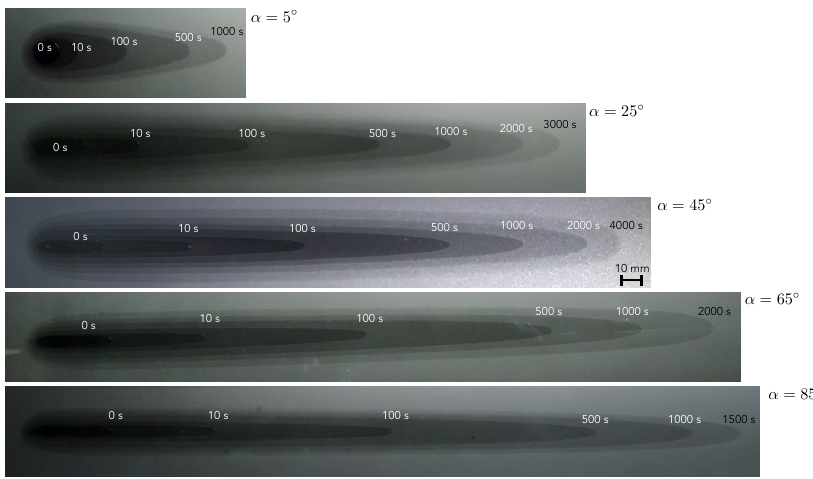
Figure 4: Silicone oil – Superimposition of several pictures of the oil stain, taken from above, for five angles α of inclination (5, 25, 45, 65, and 85 ◦ , from top to bottom). In each case the volume of the droplet was 75 µ L. The height of each image is 40 mm. The times at which the pictures were taken are indicated in the different figures and range from 0 to 4000 s. The complete set of images (taken every second) was analysed to obtain the area and the speed of the spreading presented in Fig.